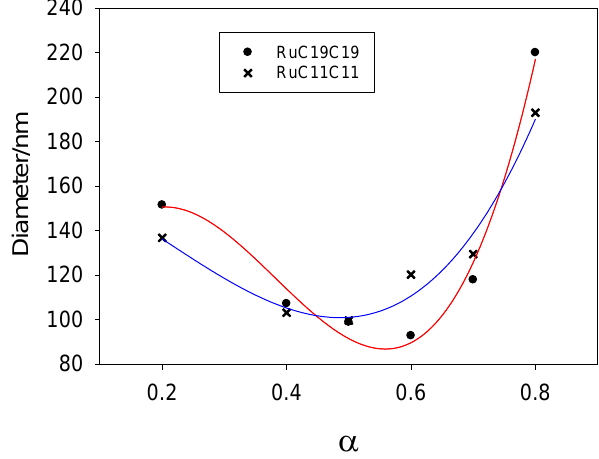
Figure 3. Size (diameter) of liposomes prepared from DOPE and Ru-based lipids (RuC11C11 or RuC19C19) at different compositions. Solid lines only indicate the trend obtained in the size with α value.